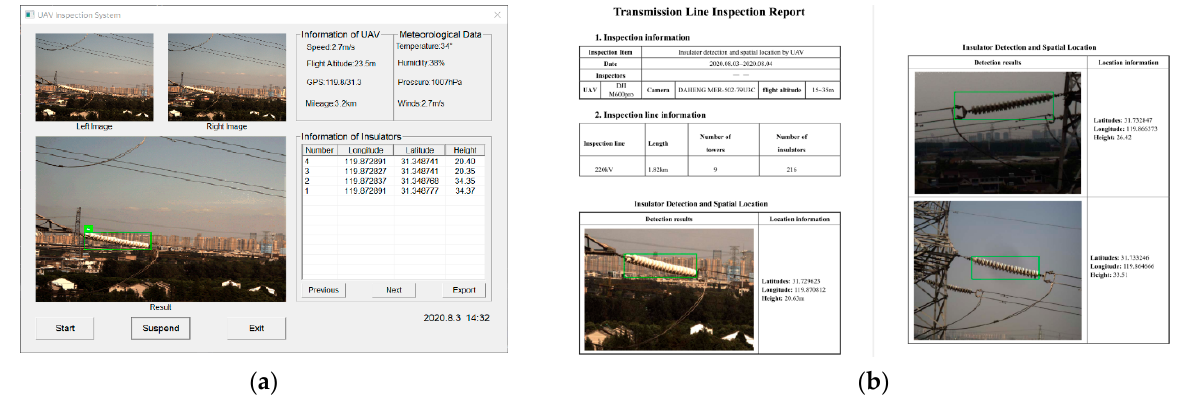
Figure 15. Results of transmission line inspection system: ( a ) interface of inspection information; ( b ) example of automatically generated patrol report.